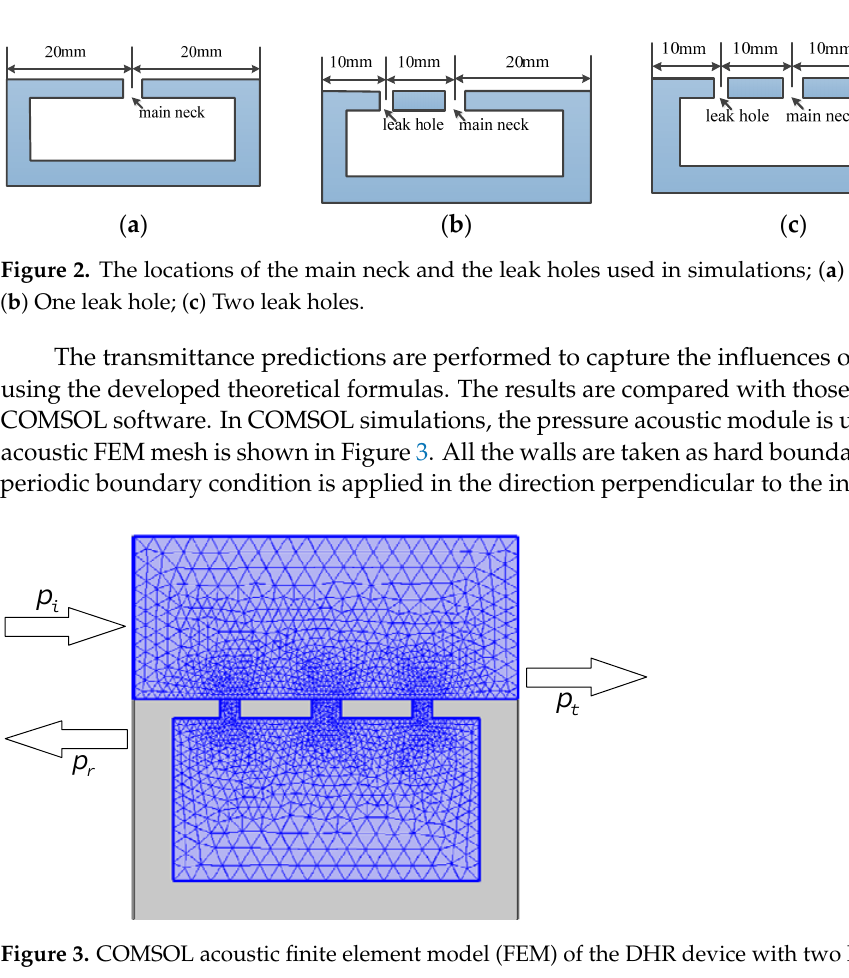
( b ) Figure 4. Effects of the number of leak holes on the transmission properties of the DHR device. The solid lines represent the theoretical results, while the circle lines represent the COMSOL predictions. ( a ) Amplitude vs. frequency; ( b ) Phase shift vs. frequency. In fact, the influence of leakage on resonance frequency can be explained by the the- ory of acoustic impedance. Note that all the neck impedances can be considered as paral- lel, so the reciprocal of the overall impedance neck r